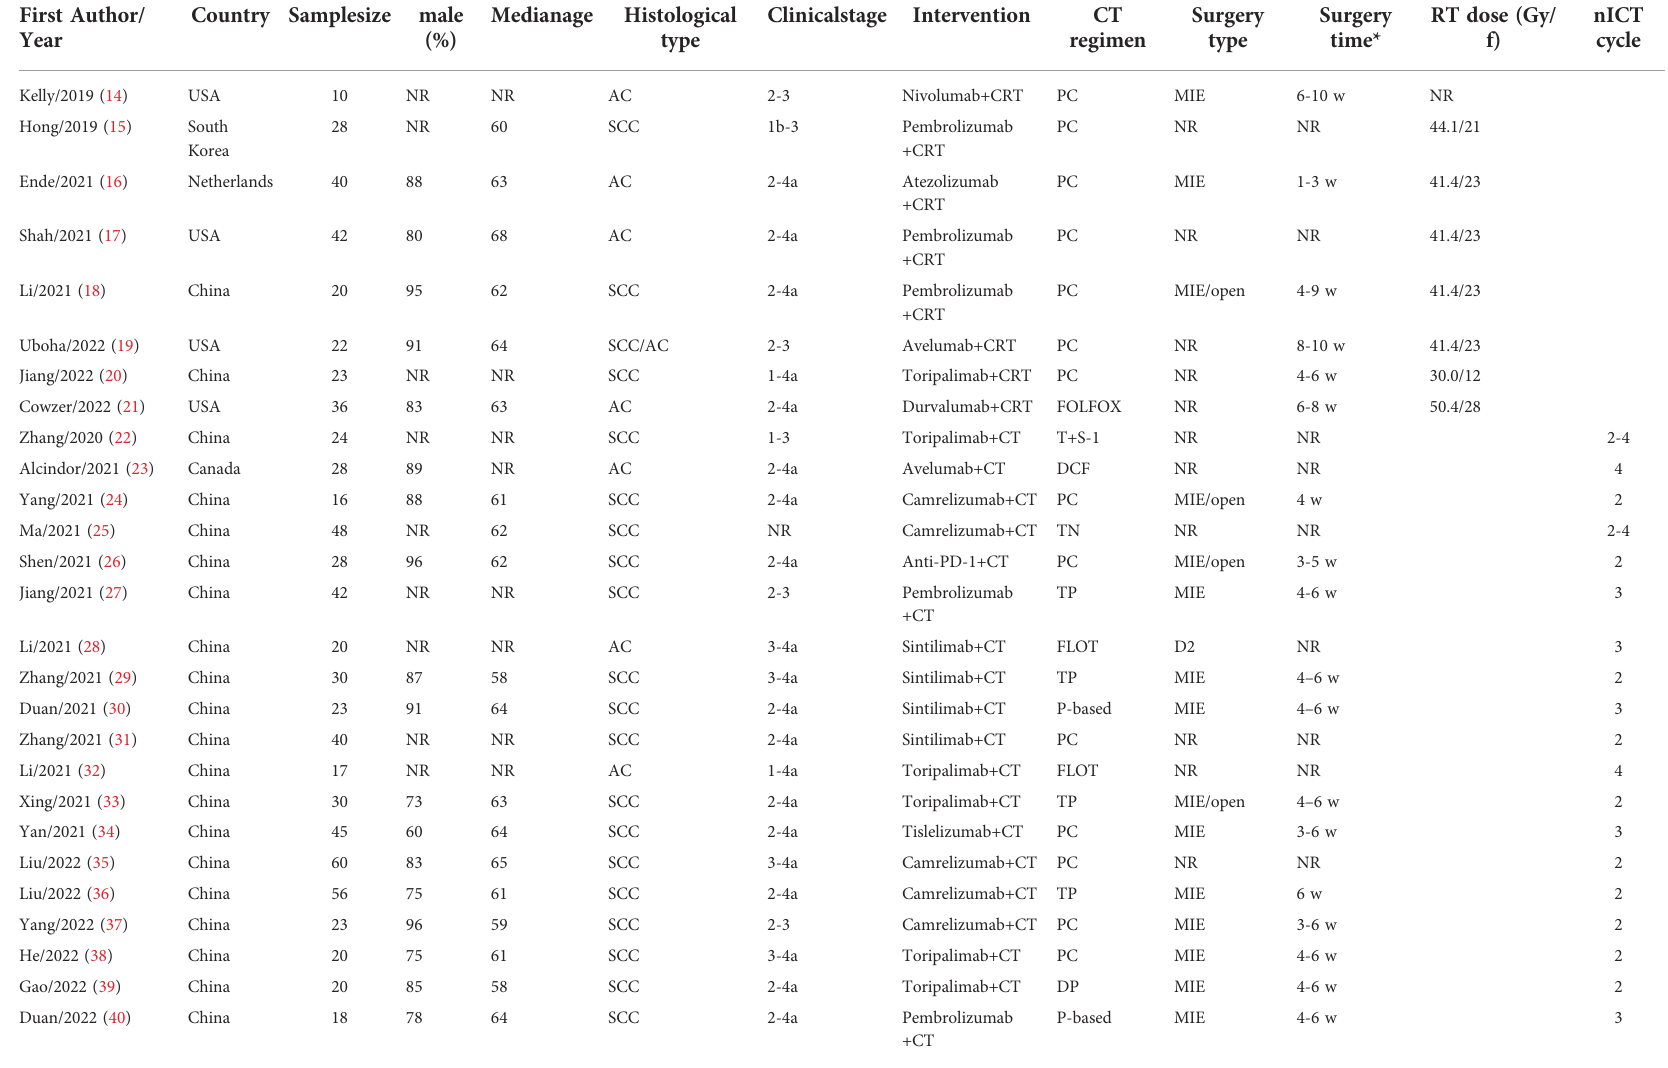
nICT, immune checkpoint inhibitor in combination with chemotherapy; CT, chemotherapy; RT, radiotherapy; CRT, chemoradiotherapy; SCC, squamous cell carcinoma; AC, adenocarcinoma; PC, paclitaxel+carboplatin; T, paclitaxel; DCF, docetaxel +cisplatin+5-FU; TN, paclitaxel+nedaplatin; TP, paclitaxel+cisplatin; P-based, platinum-based; FLOT, docetaxel+oxaliplatin+5-FU; DP, docetaxel+cisplatin; MIE; McKeown or Ivor-Lewis esophagectomy; w, week; NR, not reported; f, fraction. *Surgery time: time interval between surgery and the last dose of neoadjuvant